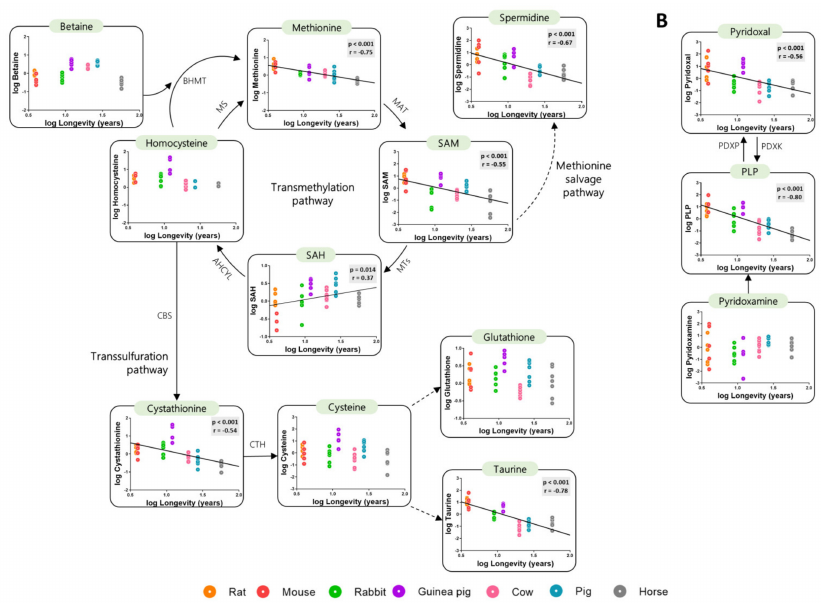
Figure 2. Heart methionine-related metabolites are negatively correlated with animal longevity. Heart concentration of metabolites involved in the transmethylation and transsulfuration pathways ( A ) and vitamin B6 metabolites ( B ). The concentrations of heart metabolites are reported in log(mmol/g tissue). Pearson correlation was performed. Linear regression was applied when significant relationships were found. The minimum significance level was set at p < 0.05. All metabo- lite values were log-transformed in order to accomplish the assumptions of normality. Enzyme codes refer to: Methionine synthase (MS); Betaine-Homocysteine S-methyltransferase (BHMT); Methionine adenosyltransferase (MAT); Methyltransferases (MTs); Adenosylhomocysteinase-like 1